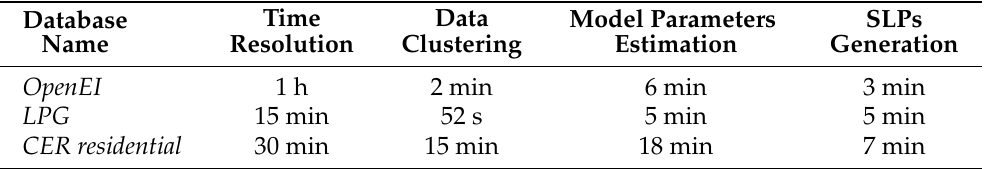
Table 2. Processing times for preliminary data aggregation and clustering, Markov chain parameters estimation and SLP generation. The reported values refer to the steps shown in Figure 1 and are obtained using a PC equipped with an AMD Ryzen™ 5 2600 6C/12T microprocessor, 32 GB of RAM, Linux (Ubuntu 18.04) and Matlab R2019a enhanced with the Parallel Computing Toolbox. The processing times for clustering and model parameters estimation refer to the whole set of clusters for a single season. The SLP generation times refer to one-week-long time series, assuming to generate a number of profiles equal to the number of LPs in the original input data